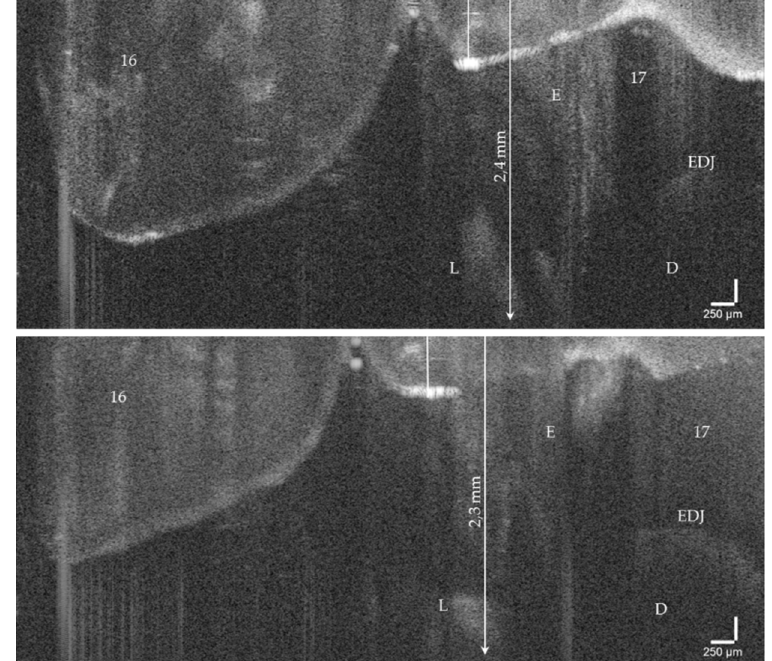
Figure 6. OCT cross-sectional image of an early approximal enamel carious lesion (L; ICDAS, Code 2) on tooth 17 in vivo. The lesion can be localized to a depth of 2.4 mm below the enamel surface. As a result of focusing on deeper structures, the tooth surface is flipped over again. Enamel (E), dentin (D), enamel-dentin junction (EDJ). The vertical scales are related to refractive index n = 1.0 (see the remark in Figure 4).